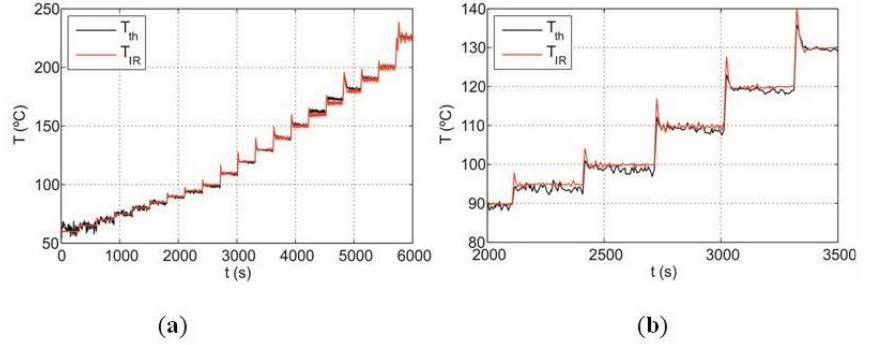
Figure 14. Temperature measured with a thermocouple and the infrared sensor, respectively, for a metal disk sample: ( a ) temperature ranging from 60 to 250 °C; ( b ) temperature ranging from 90 to 130